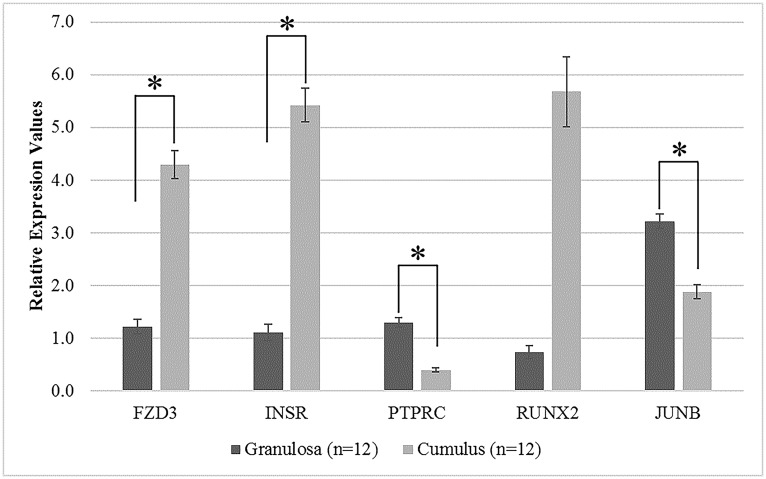
Relative expression of candidate genes (FZD3, INSR, PTPRC, RUNX2 and JUNB) obtained from qRT-PCR analysis.The validation study was performed with 12 independent patients who provided two somatic cell types: CC and MGC. Relative expression values for each gene is shown on the y-axis in arbitrary units. The data are presented as mean ± SEM. Asterisk (*) indicates a significant difference (p<0.05) in gene expression between granulosa and cumulus cells.